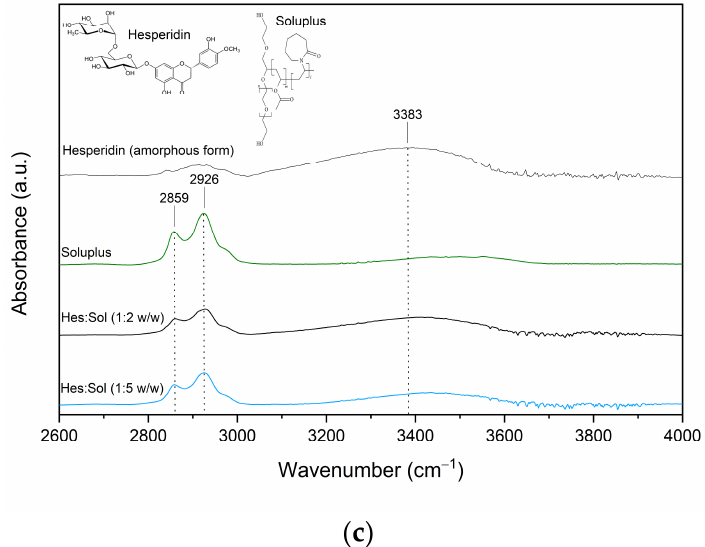
Figure 4. The FT-IR analysis-Hesperidin (amorphous form), Soluplus ® , Hes:Sol 1:2, Hes:Sol 1:5; ( a ) range 400–1000 cm −1 , ( b ) 1000–1800 cm −1 , ( c ) range 2600–4000 cm −1 . The changes in the nature of Sol’s bands mainly concern a reduction in intensity.